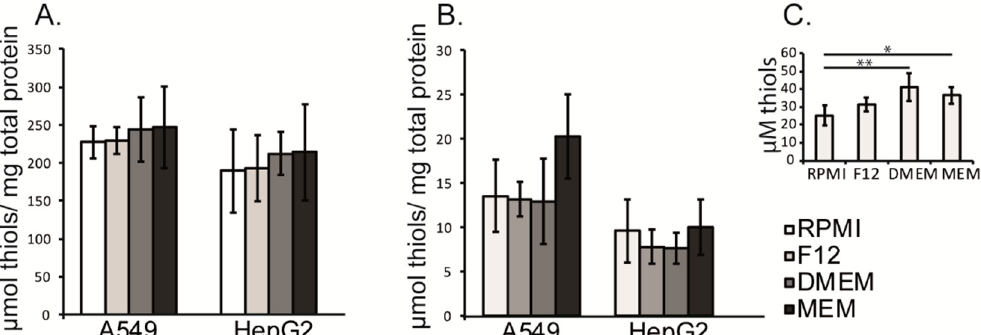
Figure 3. Intracellular and extracellular thiol content. The 5,5’-Dithiobis-(2-Nitrobenzoic Acid (DTNB) assay was used to measure the thiol concentration; ( A ) total intracellular thiols. ( B ) Extracellular thiols measured 5 h after the addition of fresh media. ( C ) Baseline thiol content measured in fresh media. Data is presented as mean +/ − standard deviation. Statistical analysis was performed by using the Kruskall–Wallis test ( n =